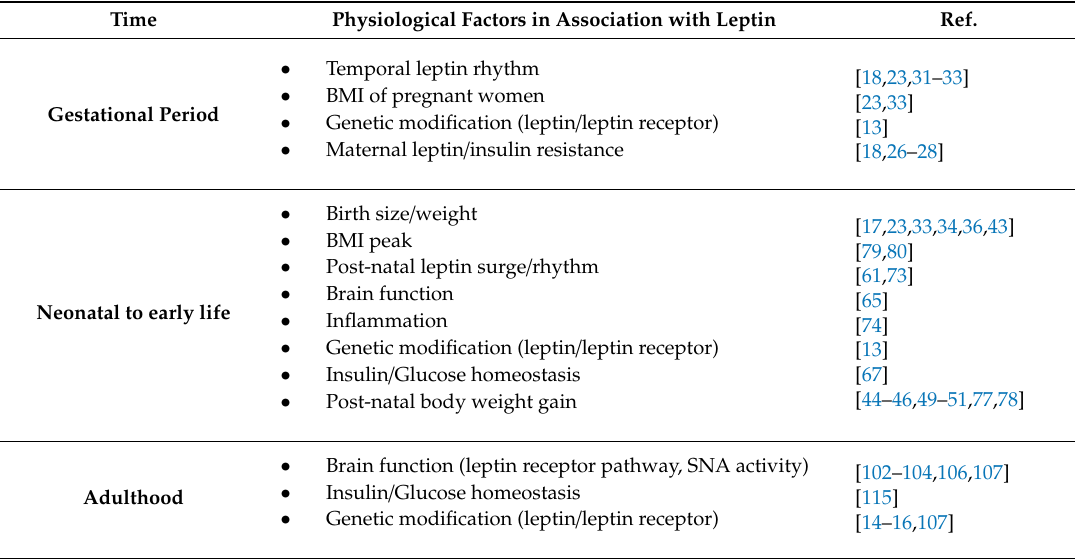
Table 1. Temporal leptin-associated physiological factors determining future cardiometabolic fate. Time Physiological Factors in Association with Leptin